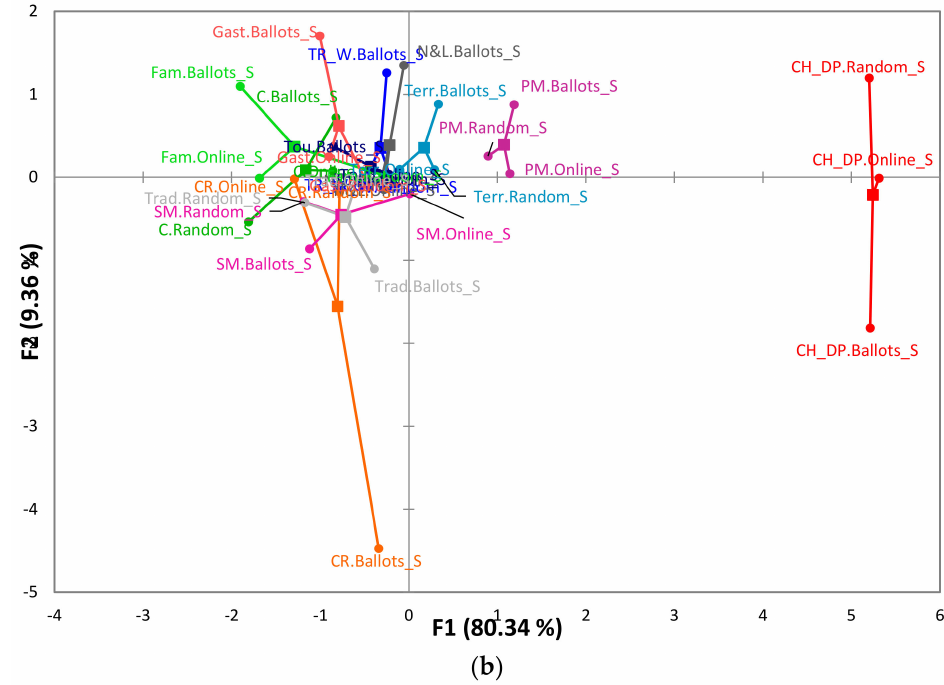
Figure 3. MFA of the social representations identified in the three study samples. ( a ) MFA of the social representations of online and ballot paper surveys. ( b ) MFA of the social representations of the three study samples. Note: all representations identified in the two studies were abbreviated as follows: cheese and dairy products (CH_DP); tourist resource (TR_W); culture (C); pueblo m á gico (PM); nature and landscape (N&L); craft (CR); tourism (Tou); family (Fam); State of Mexico (SM); gastronomy (Gast); territory (Terr); tradition